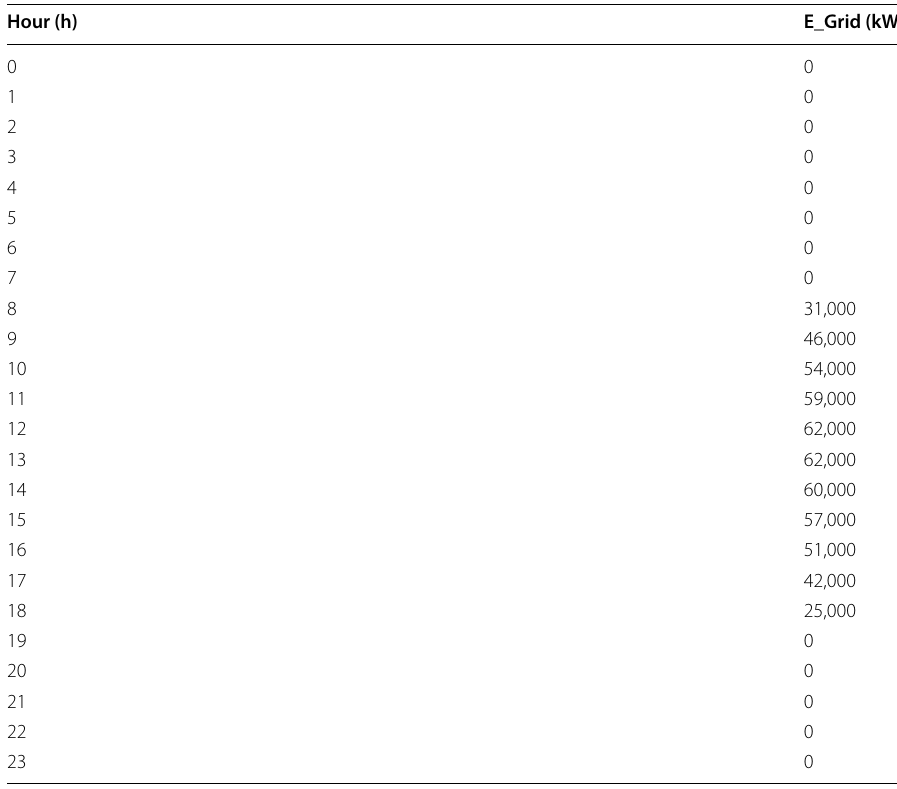
Table 7 Energy injected into the grid (annual hourly